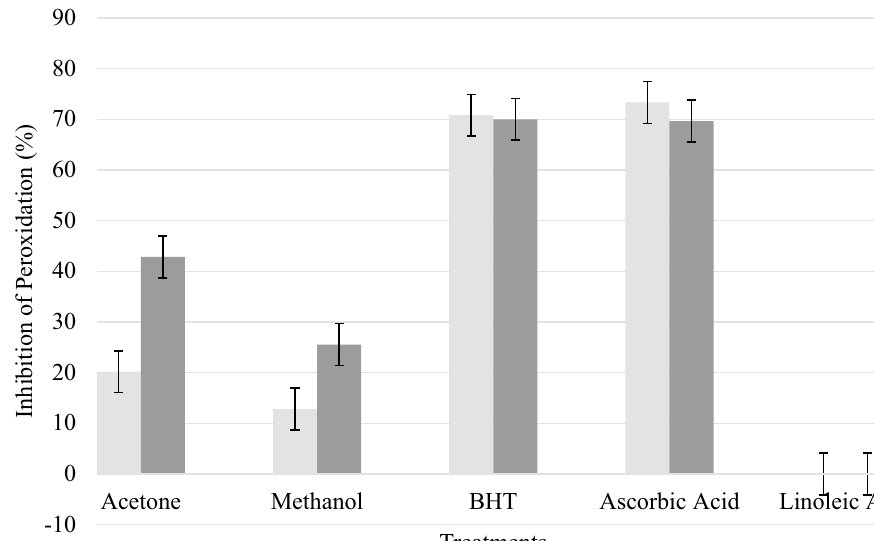
Fig. 5 Antioxidant properties of A. berlandieri and A. rigidula extracts (5 mg/25 mL) deter- mined by ferric thiocyanate method. Positive controls (BHT and ascorbic acid) and negative control (linoleic acid) were used to compare results from each extract. Duncan’s Multiple Range Test indicated a significant difference as shown by the non-overlapping con- fidence intervals. Mean values are from three replicates run in